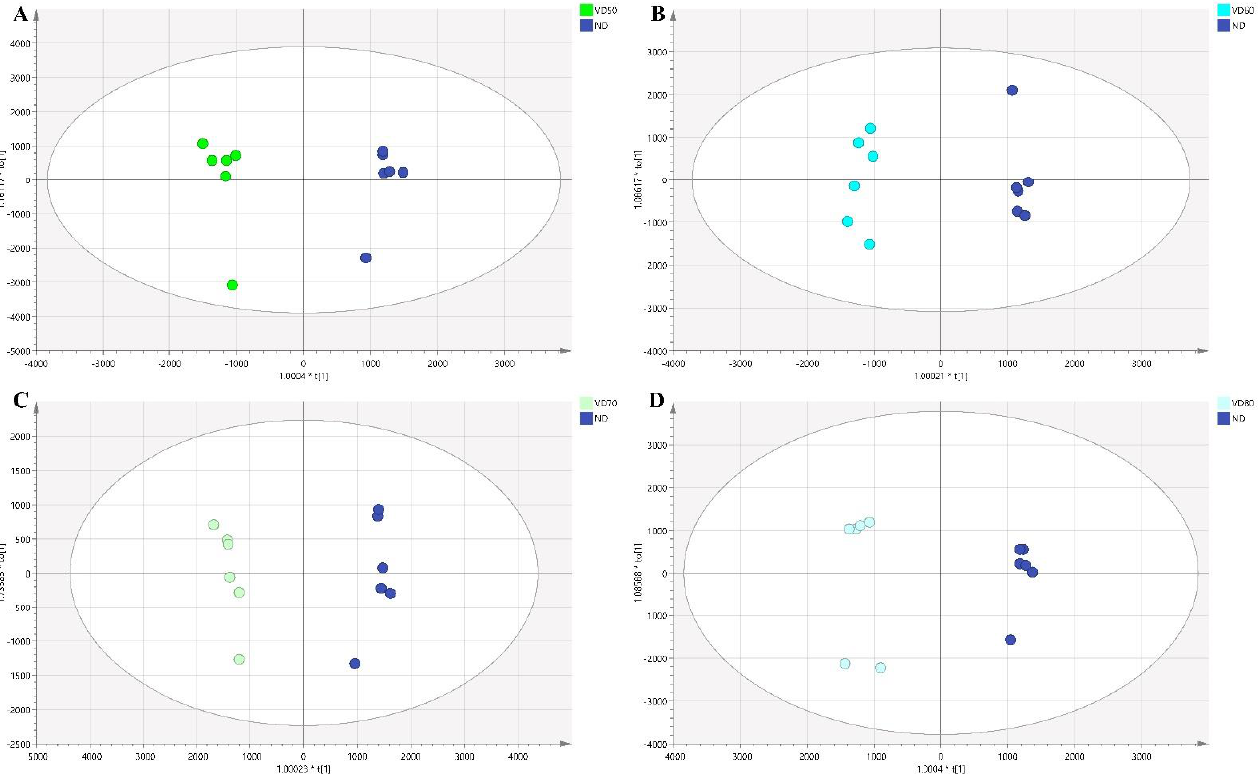
Figure 5. The OPLS − DA scores plot for comparisons between the different temperatures of vacuum drying (VD) and natural drying (ND) ( n = 6): ( A ) for VD50 and ND, ( B ) for VD60 and ND, ( C ) for VD70 and ND, and ( D ) for VD80 and ND.